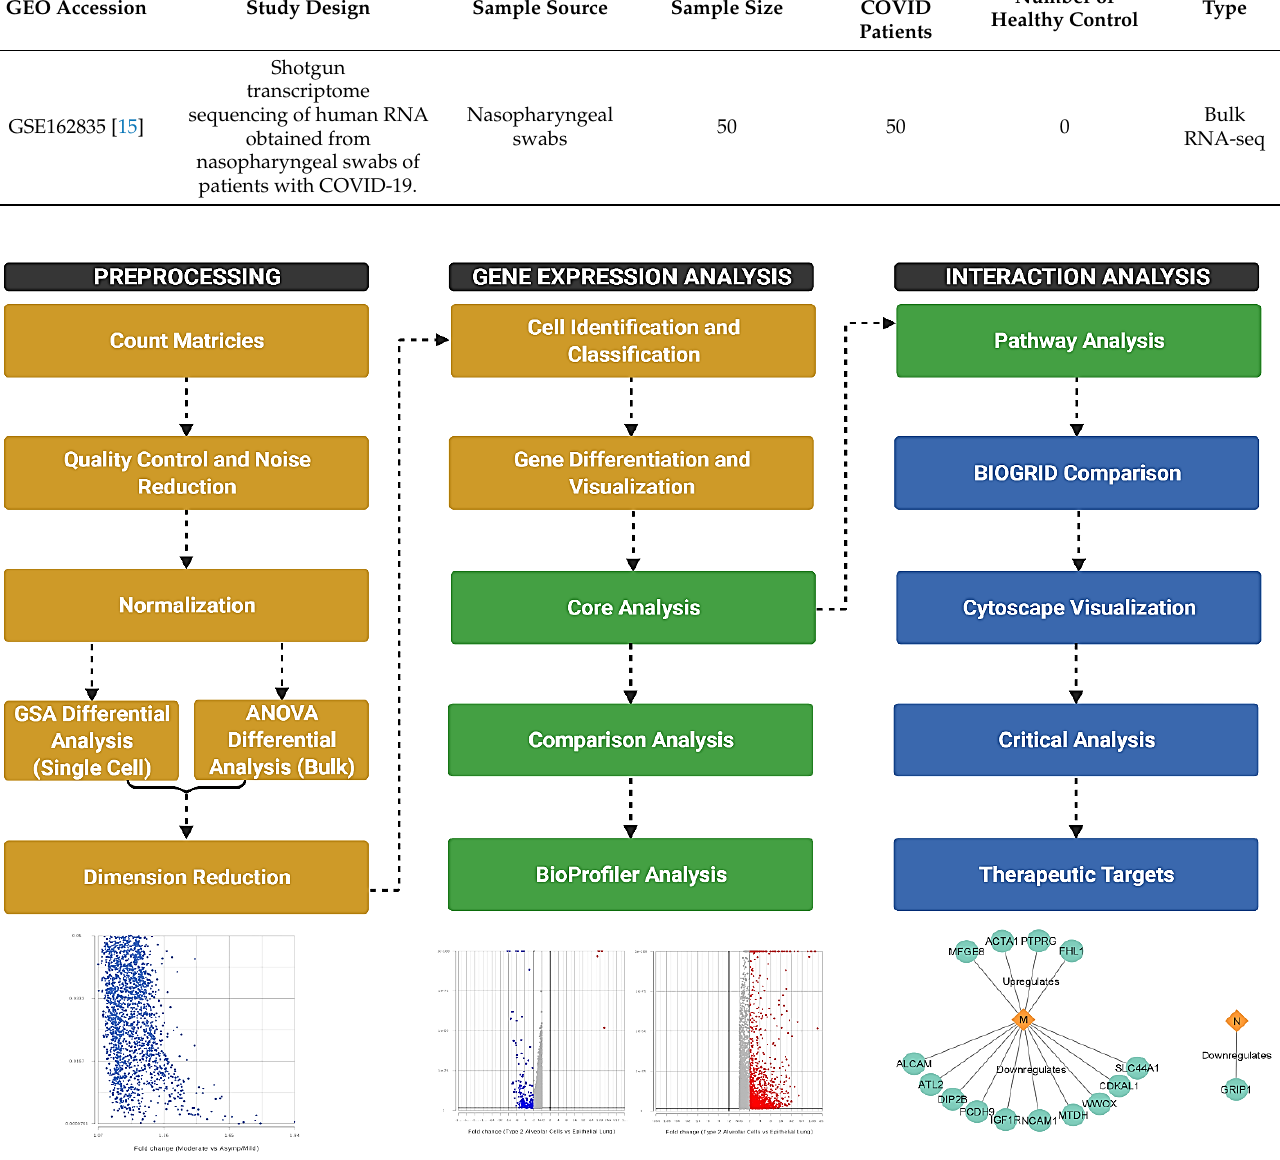
Figure 1. Flowchart depicting the methods of the experiment. Count matrices were imported from GEO and processed for further analysis. The three major components of the study were preprocessing, gene expression analysis, and interaction analysis. Yellow steps were performed in Partek Flow, green steps in IPA, and blue steps in other software. Generated in Biorender.